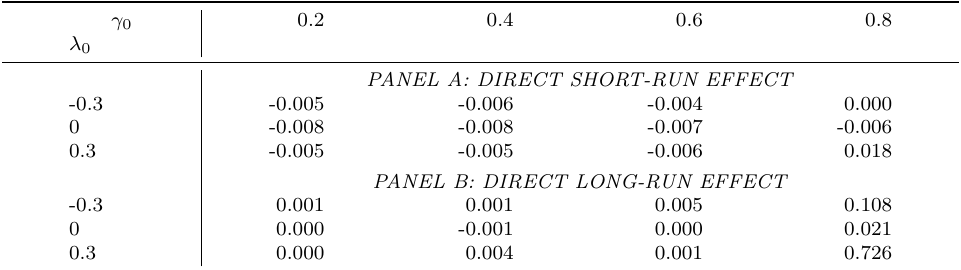
Table 3: Bias of marginal direct short- and long-run effects of Team